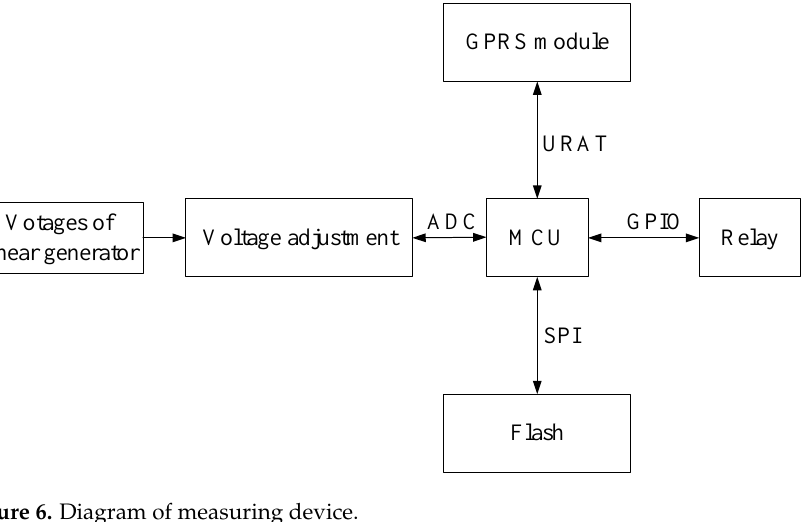
Figure 6. Diagram of measuring device.